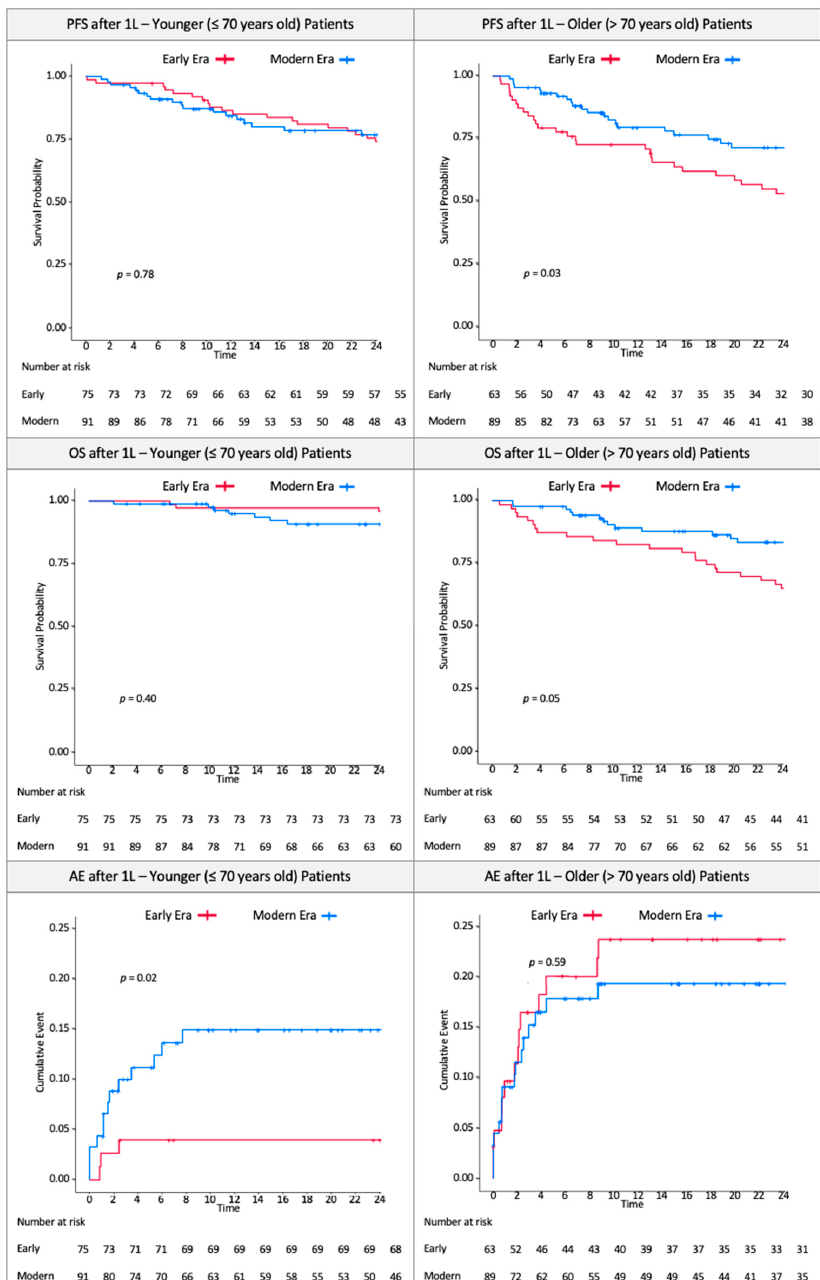
Figure 4. Progression-free survival, overall survival, and adverse event-related discontinuation in veterans with Walden- ström macroglobulinemia, 2006 to 2019. 1 L: first-line treatment; AE: adverse event; Early: early era, 2006–2012; Modern: modern era, 2013–2019; OS: overall survival; PFS: progression-free